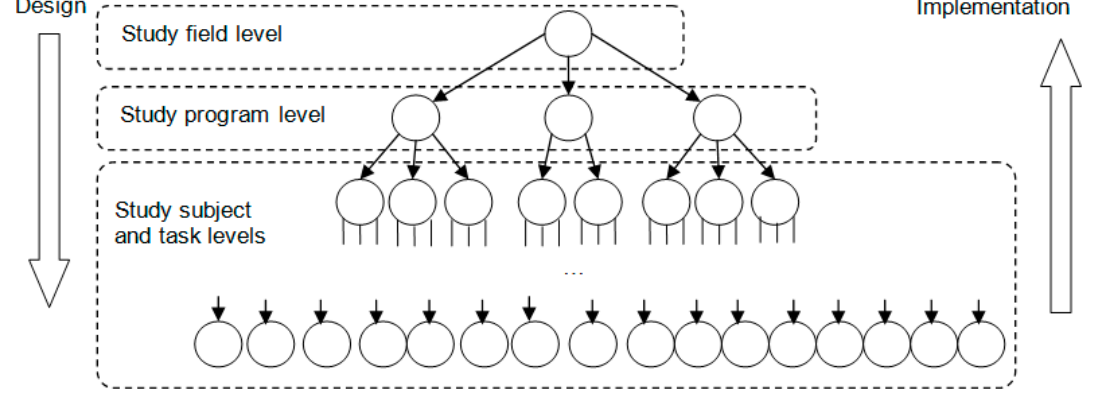
Figure 2. Principle scheme of the competency tree structure.